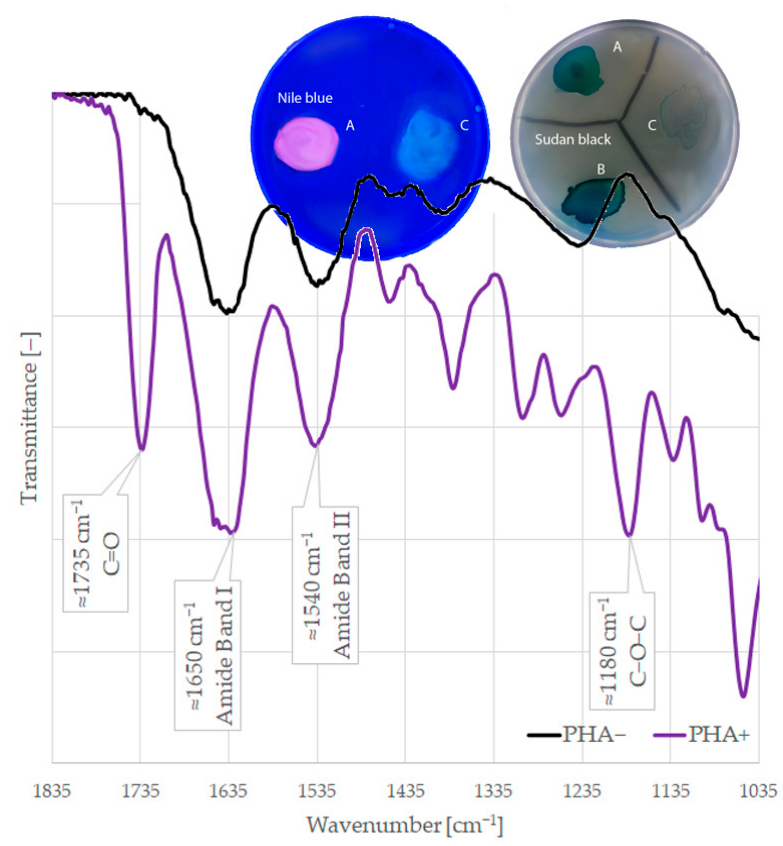
Figure 2. Phenotypic detection of PHA production: Nile blue staining; Sudan black staining; and detection by FTIR (A) Cupriavidus neactor ATCC 17699, (B) Pseudomonas extremorientalis are PHA+ and (C) Escherichia coli DH5 α is PHA − .